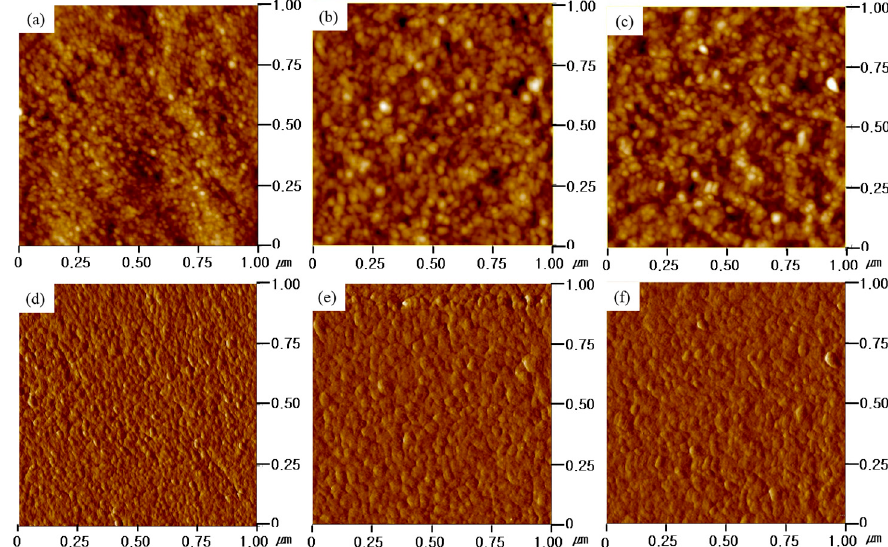
Figure 8. Atomic force microscopy (AFM) height images of membranes of ( a ) SPABES-PAE (1:2), ( b ) SPABES-PAE (1:1), and ( c ) SPABES-PAE (2:1); AFM phase images of membranes of ( d ) SPABES-PAE (1:2), ( e ) SPABES-PAE (1:1), and ( f ) SPABES-PAE (2:1).